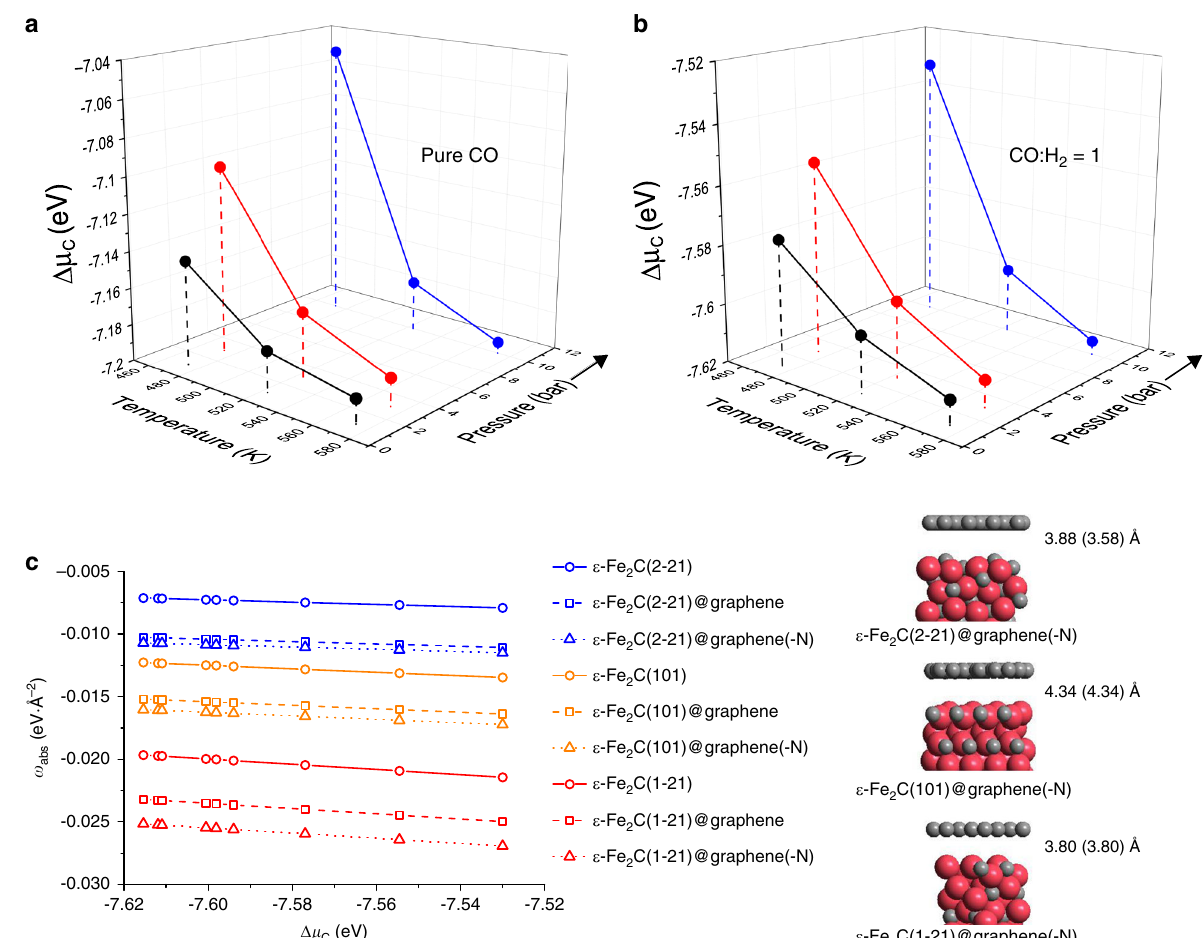
Fig. 5 DFT calculation of graphene con fi nement on ε -Fe 2 C. a Relative chemical potential of carbon ( Δ μ C ) for carburization by CO (2CO → C + CO 2 ). b Relative chemical potential of carbon ( Δ μ C ) for carburization by syngas (4CO + 4H 2 → 2C + CO 2 + 2H 2 O + CH 4 ). c Surface-normalized carbon absorption energy ( ω abs ) of ε -Fe 2 C surfaces with and without graphene(-N) layers and the most stable structures labeled by the distances between ε -Fe 2 C and graphene (data in parenthesis referring to those of